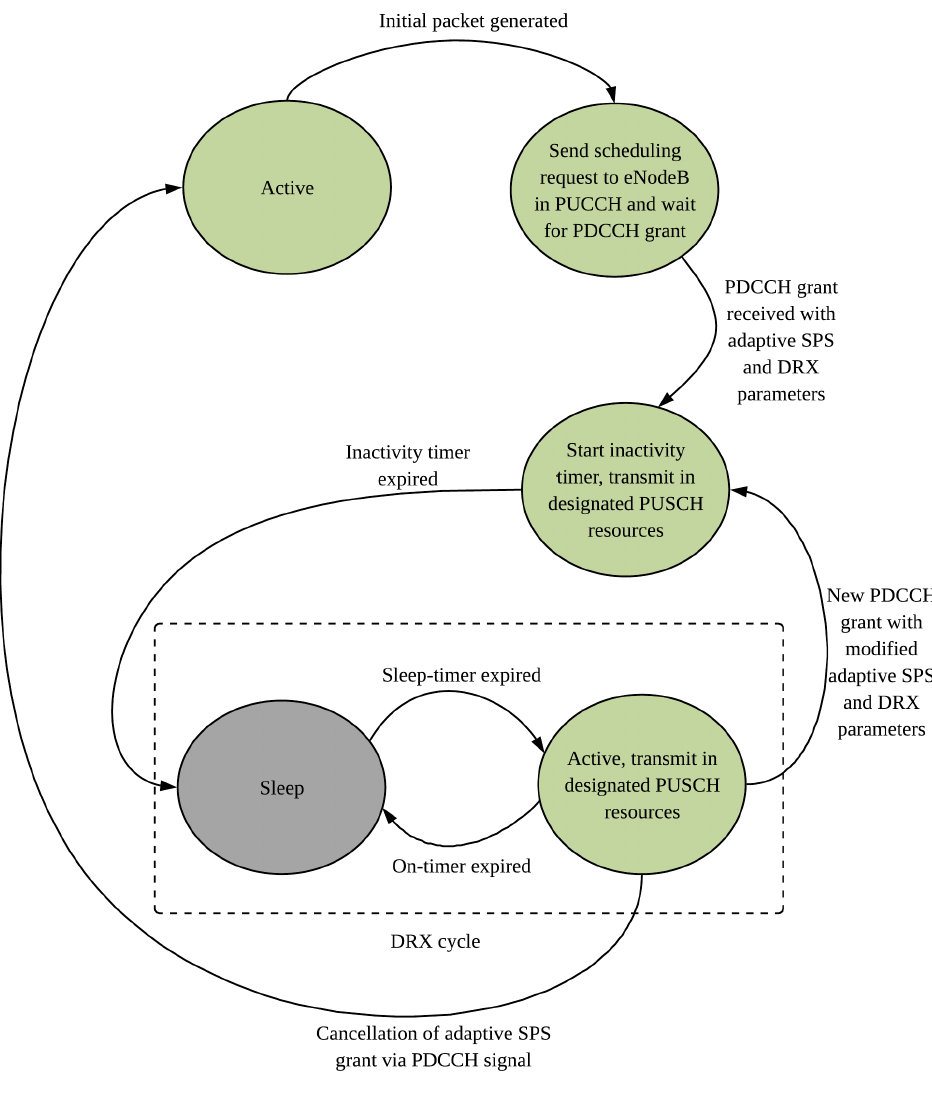
Figure 6. DRX state transitions with adaptive